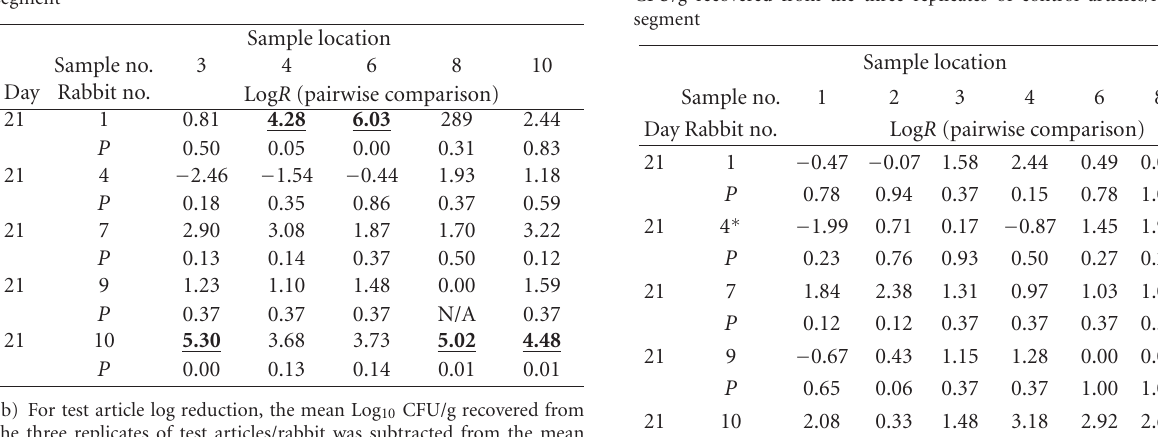
Table 3: Catheter (CFU/catheter segment) Log reduction summary tables for day 21. Log reduction values higher than 4 are bold and